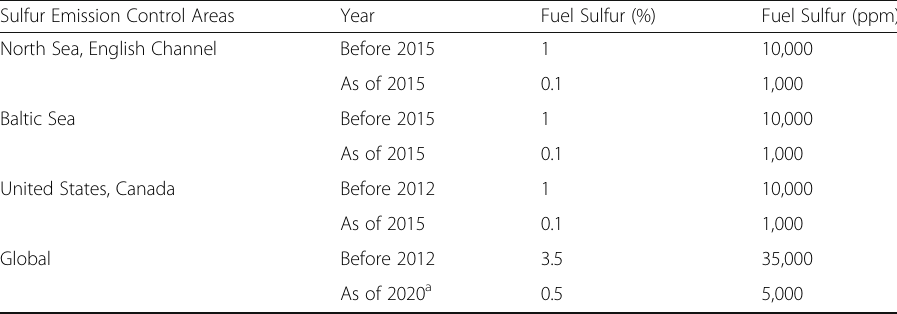
Sulfur Emission Control